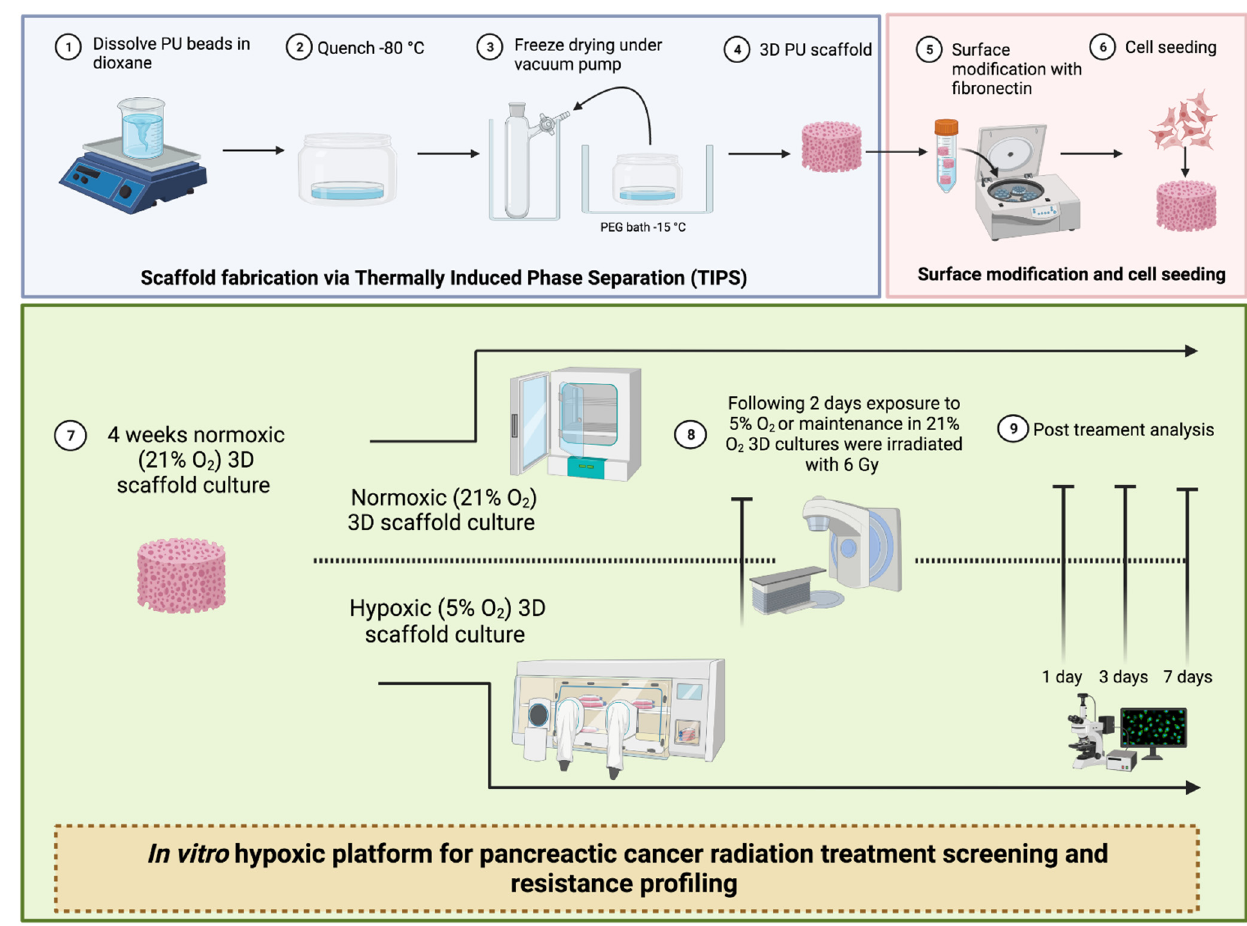
Figure A1. Experimental design. Including scaffold fabrication, surface modification, and cell seeding. Created with